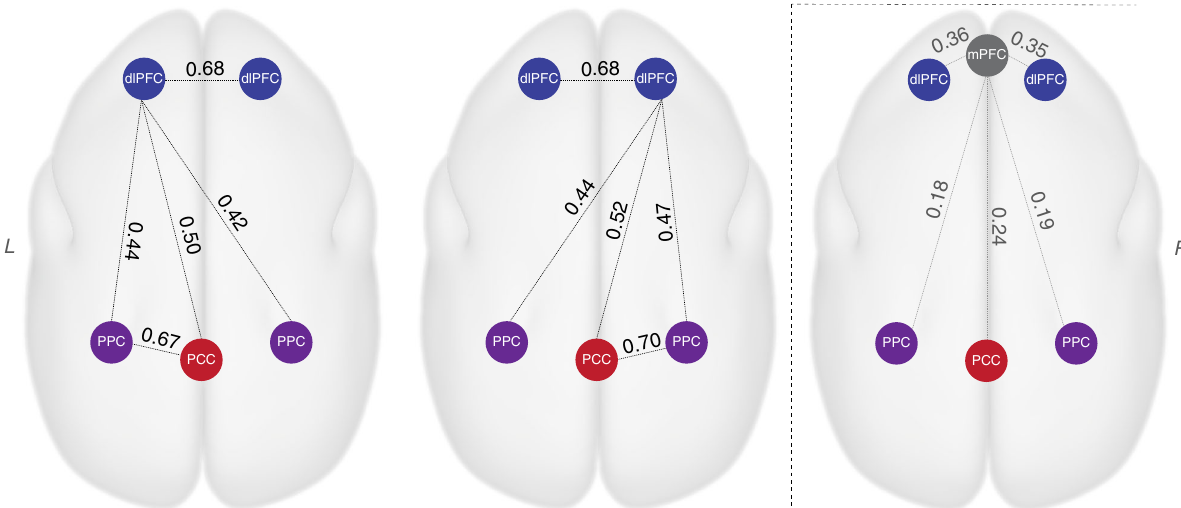
Fig. 3 Resting-state functional connectivity among each region of the marmoset DMN. The three main regions of the marmoset DMN (dlPFC, PPC, and PCC) have high correlation coef fi cients with each other, whereas the mPFC is weakly correlated to the other DMN regions. The correlation values here are mean correlations values across all marmosets. The correlations for each marmoset are presented in Supplementary Fig. 2. dlPFC dorsal – lateral prefrontal cortex, PPC posterior parietal cortex, PCC posterior cingulate and medial parietal cortex, mPFC medial prefrontal cortex. R right, L